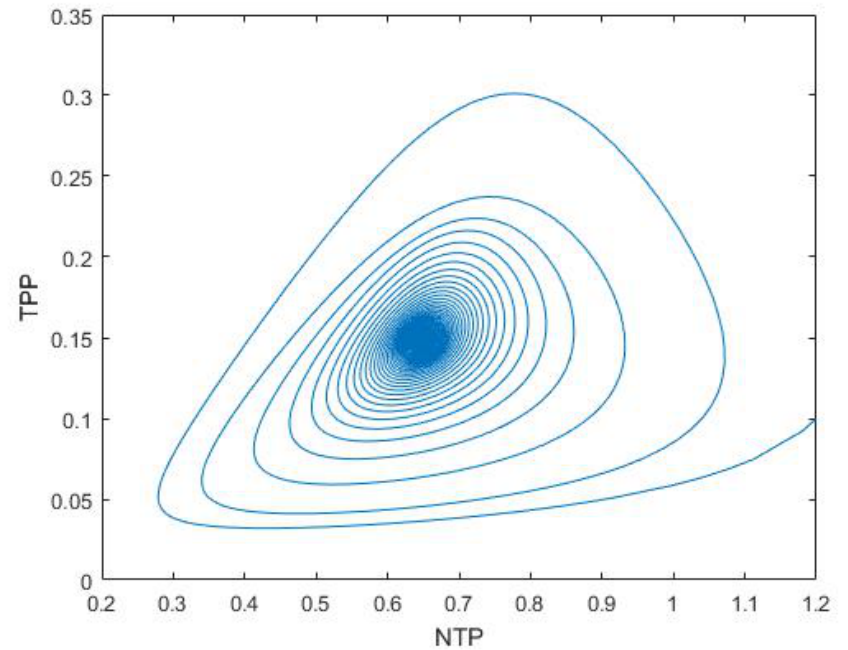
Figure 6. The asymptotical stability of the equilibrium between NTP and TPP populations for τ = τ 0 = 22.6841.